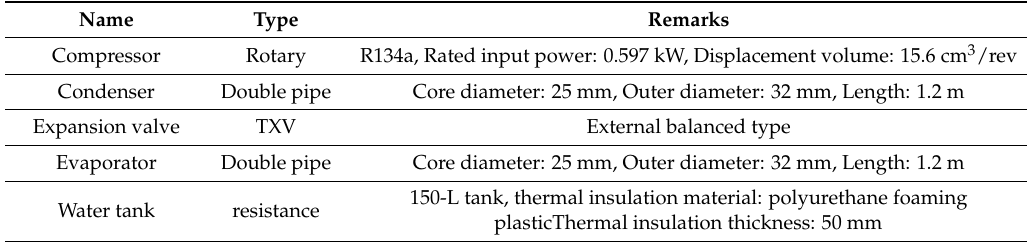
Table 1. Specification of main components of the system. TXV: thermal expansion